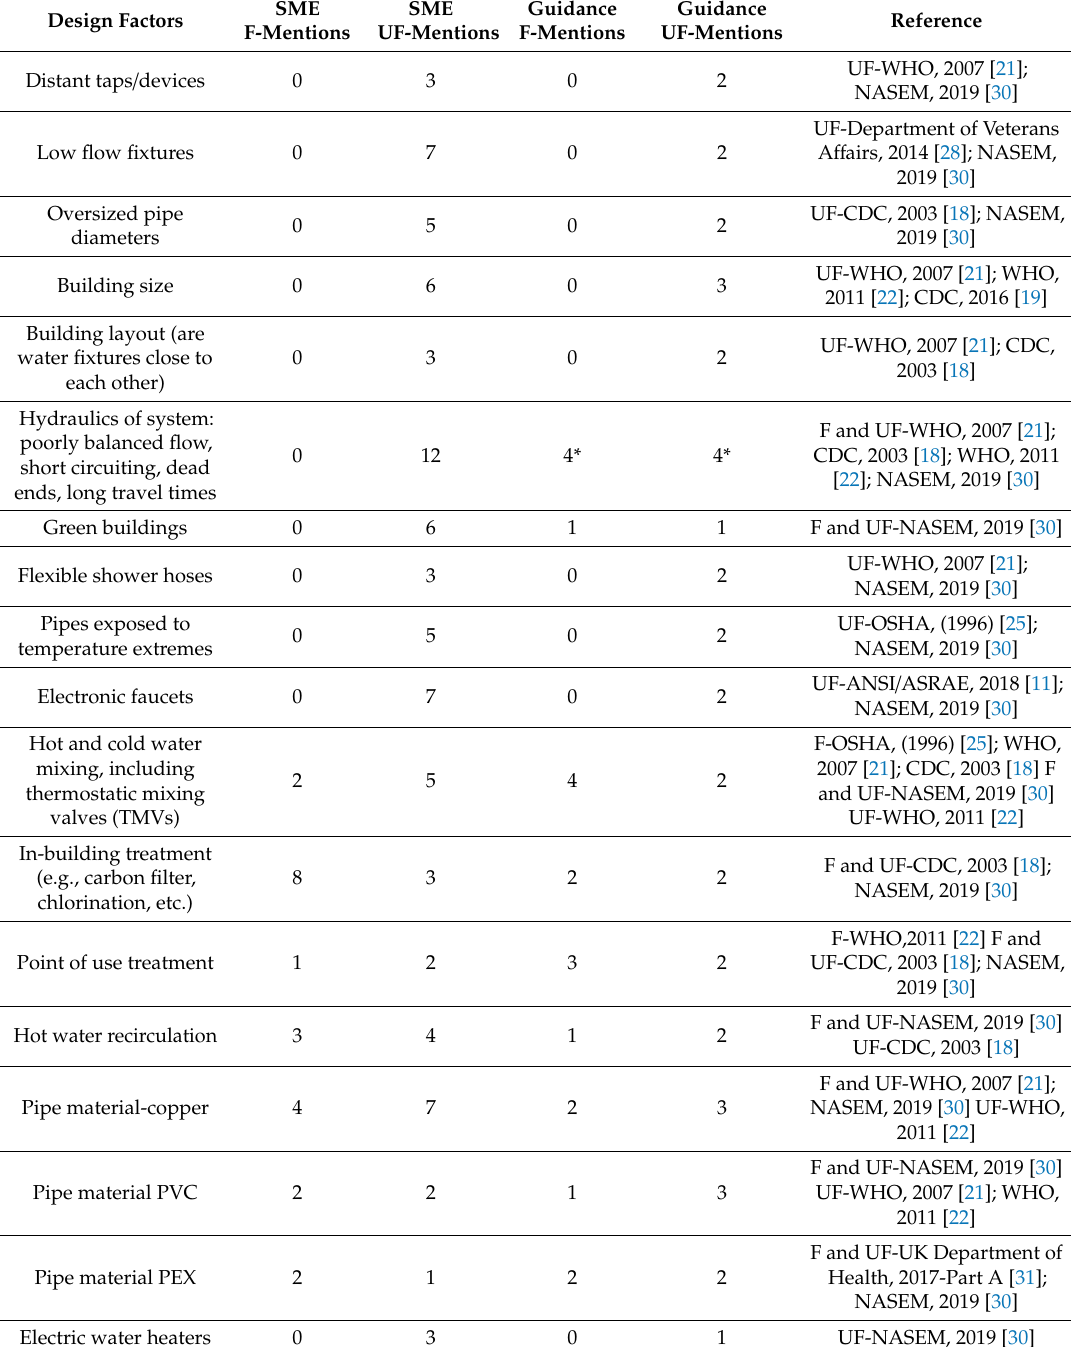
Table 2. Summary of the favorable and unfavorable views of SMEs and guidance documents on various premise plumbing design factors. F—favorable and UF—unfavorable